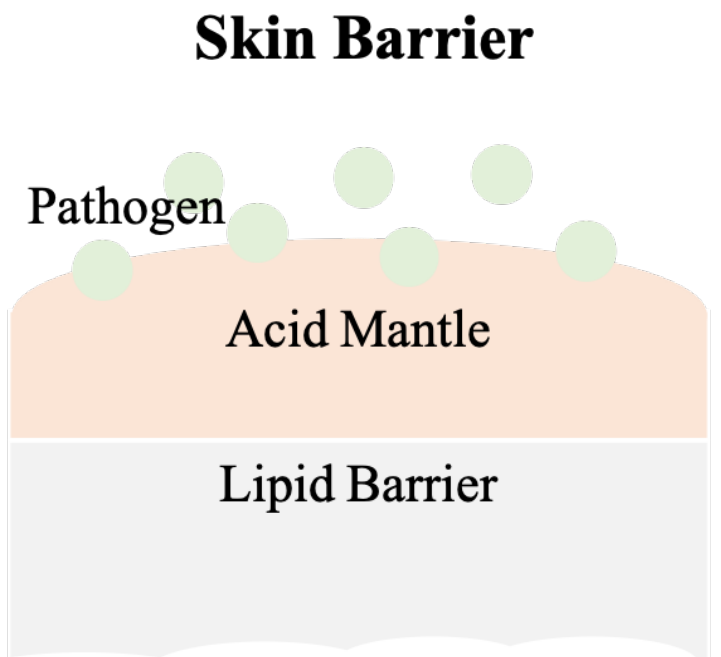
Figure 1. The scheme of the skin barrier. Lipid barrier sits atop the acid mantle and displays a pH value of 4–6. Pathogens can be various bacteria. Slight acidic environment is a disadvantage for bacterial colonization.